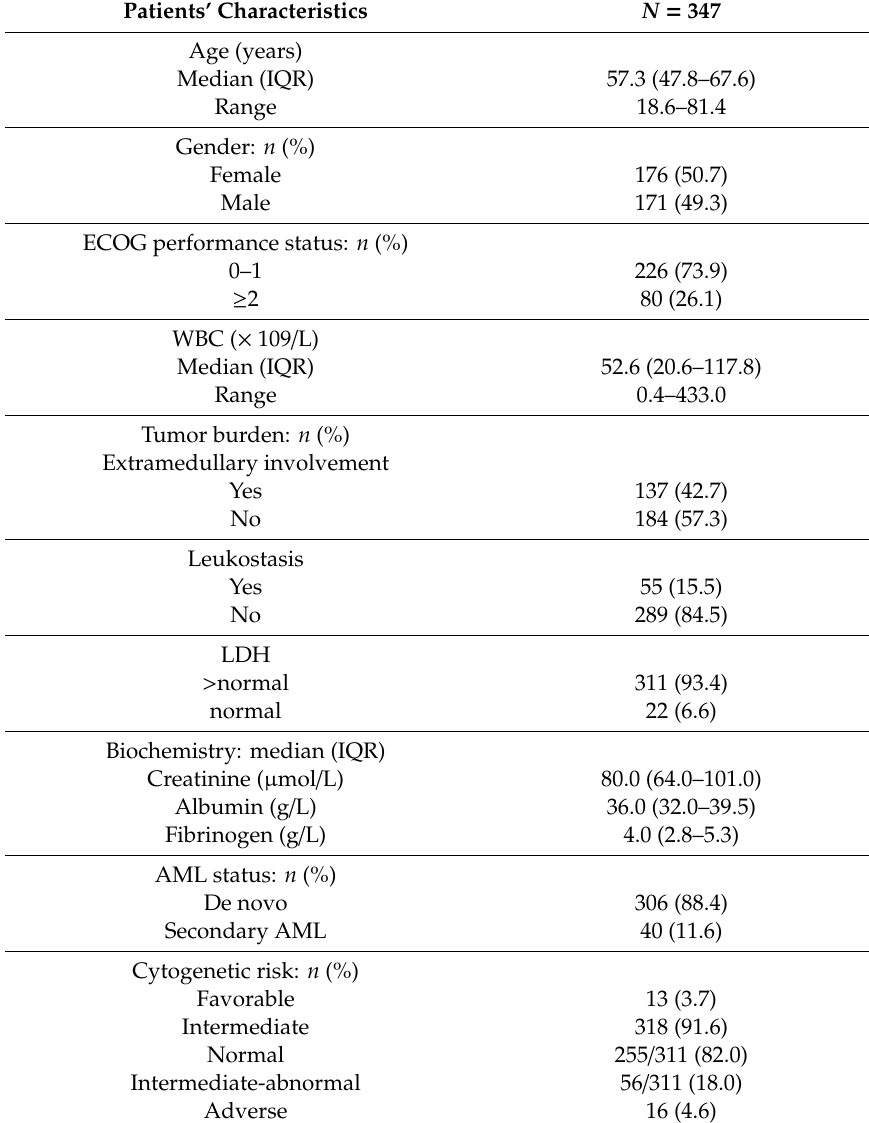
Table 1. Baseline characteristics of the 347 newly diagnosed FLT3 -mutated AML patients treated with intensive